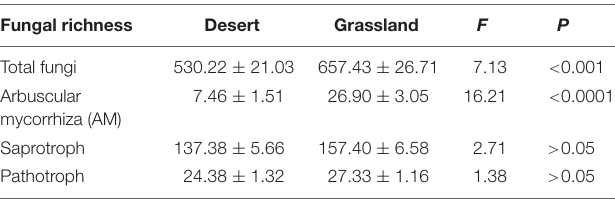
TABLE 1 | Summary statistics of the richness of total fungi and major functional groups in the desert, grassland and whole region. Fungal richness